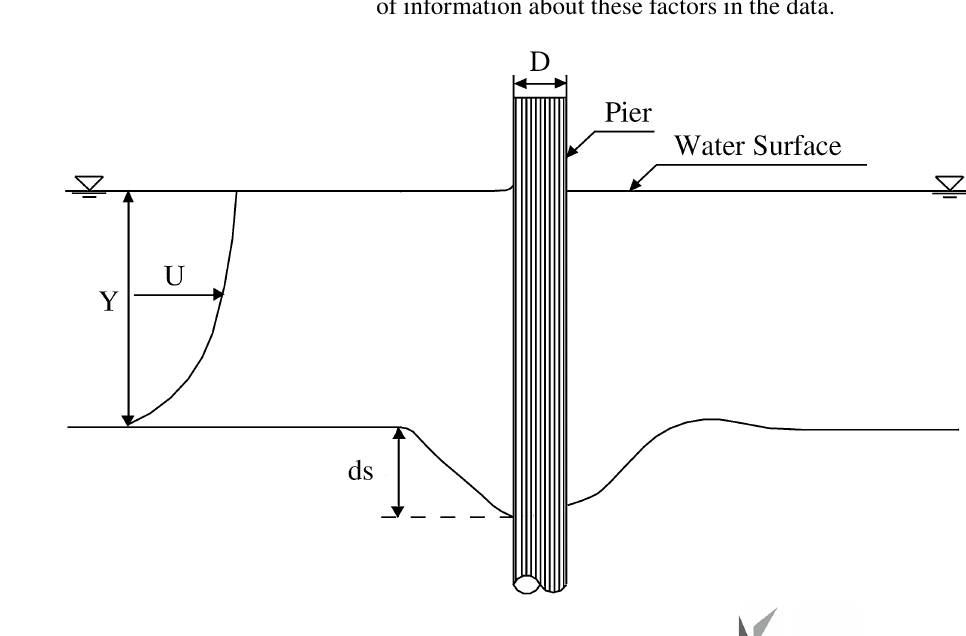
Fig. 1 Flow and local scour at bridge pier (Bateni et al.